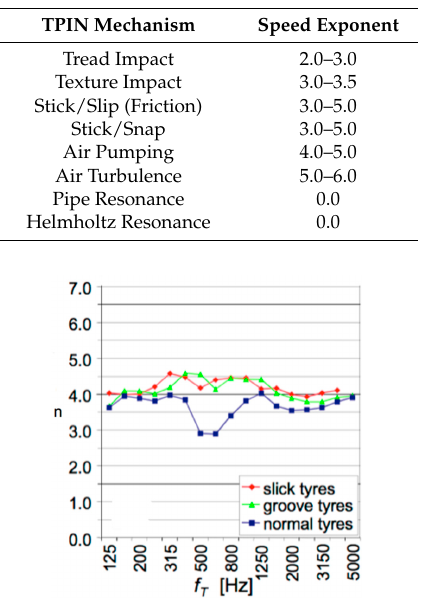
Figure 1. Speed exponent in 1/3 octave band ( n is speed exponent; f T is the center frequency of 1/3 octave band) (source from Beckenbauer and Kuijpers, 2001 [13], Figure 4; reprinted under fair use provision).